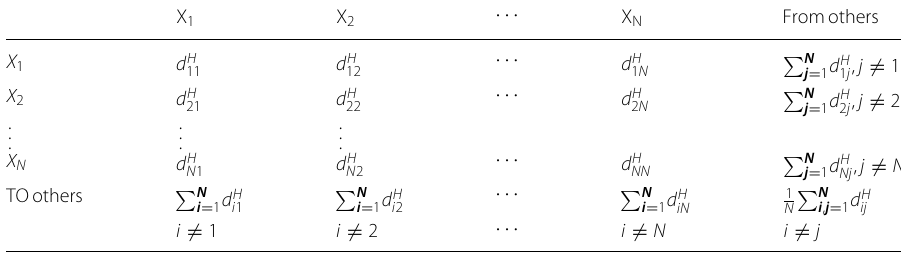
Table 4 Diebold and Yilmaz connectedness